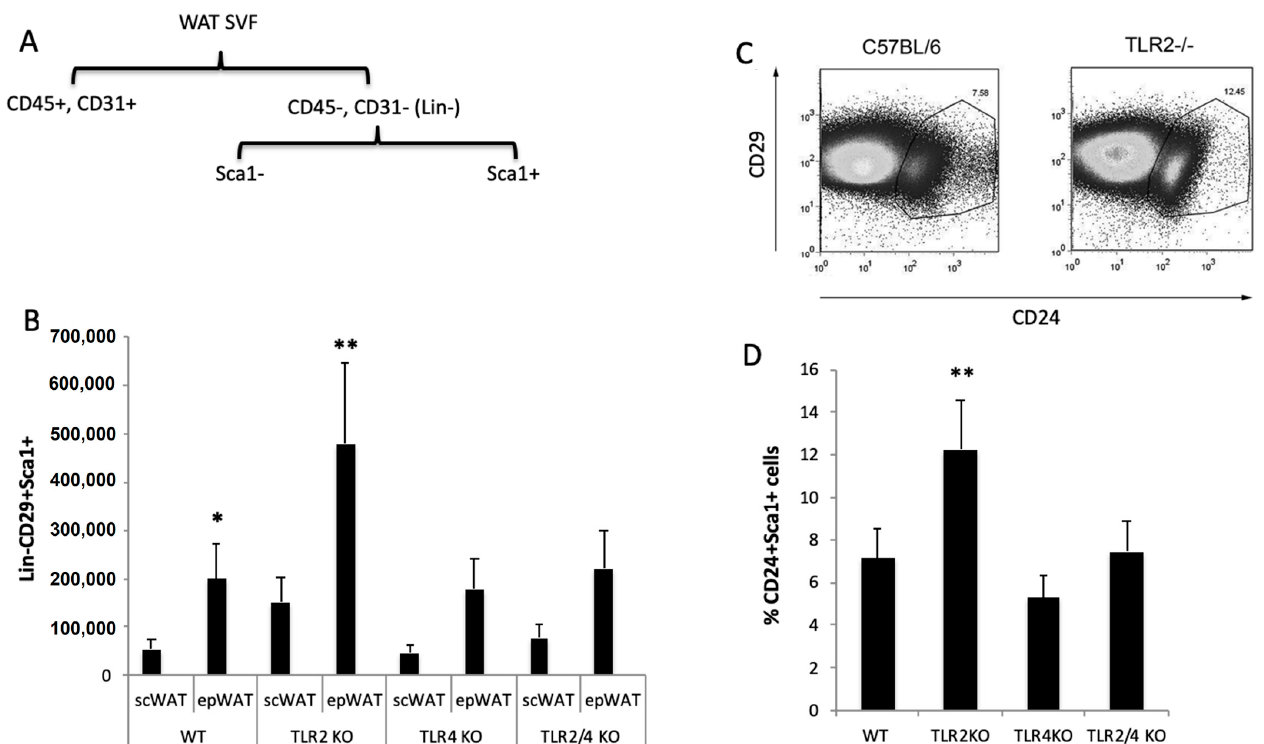
Figure 6. Higher number of adipocyte precursor cells in the WAT of TLR2 − / − mice. ( A ) Scheme of the purification of adipocyte precursors. ( B ) Total numbers of FITC-Sca-1 + cells stained with anti–CD29 in the epididymal and subcutaneous SVF of WT and TLR2 − / − , TLR4 − / − , and TLR2 − / − -TLR4 − / − mice. Average data from three experiments of three animals per group and performed in duplicate. Values are represented as mean + s.d. (* p < 0.05, ** p < 0.01) ( C ) FACS plots analysing the populations of adipocyte precursor cells in the epididymal WAT SVF of TLR2 − / − vs. WT mice. Sorted CD29 + Sca1 + cells were stained with CD24 to identify early adipocyte progenitor cells. One representative FACS experiment of four experiments performed in duplicate is plotted. ( D ) Percentage of CD24 + cells in the Lin − CD29 + :CD34 + :Sca-1 + cell population in the SVF of the epididymal WAT of WT, TLR2 − / − , TLR4 − / − and TLR2 − / − -TLR4 − / − animals. Average data from three experiments of three animals per group and performed in duplicate. Values are represented as mean + s.d. (** p <